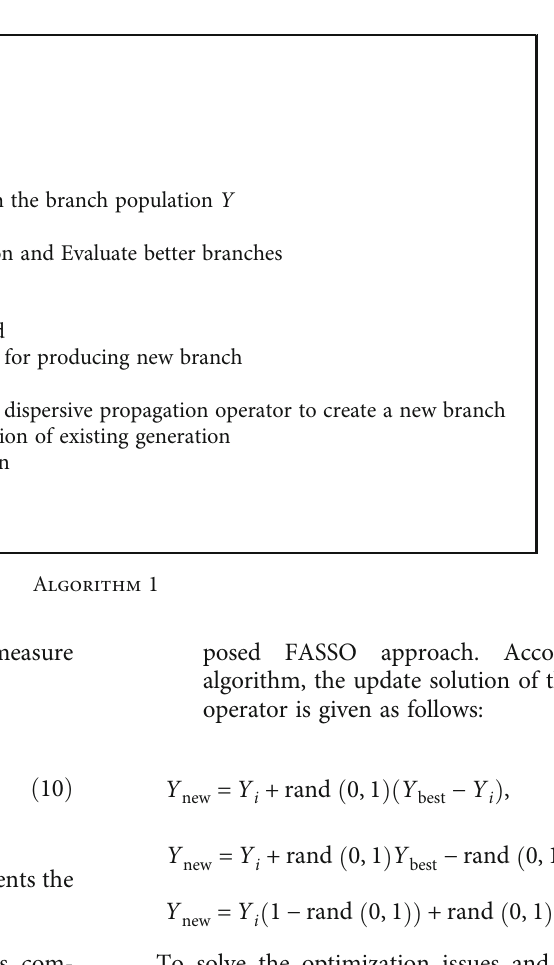
Figure 2: Architecture of the deep maxout network (DMN) classi fi